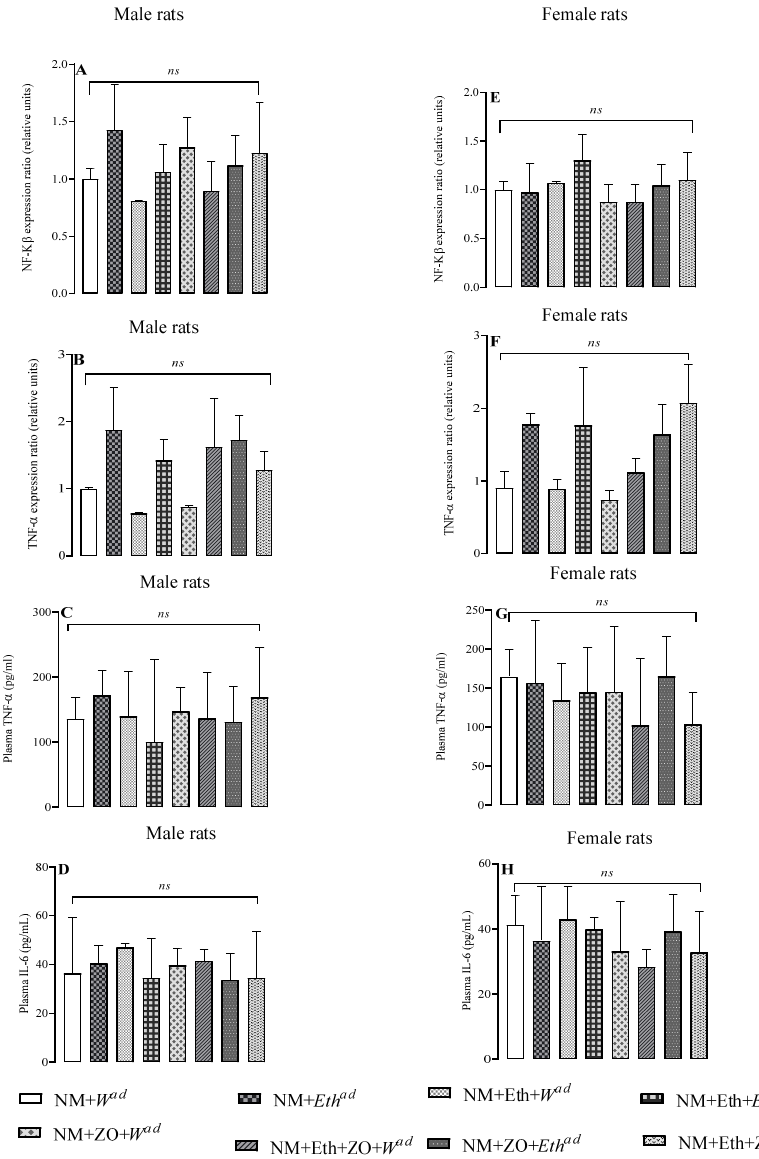
Figure 7. Effect of neonatal orally administered zingerone on NF-K β gene expression ( A , E ), TNF- α ( B , F ) gene expression, plasma TNF- α ( C , D ) and plasma IL-6 ( D , H ) concentrations in male and fe ‐ male rats drinking alcohol in adulthood. Data are presented as mean ± sd. a,a = Bars with same letters are not significantly different at p > 0.05. Control (NM + W ad )—neonatally gavaged with nutritive milk (NM) and drank plain drinking water ( W ad ) at stage III; late single hit (NM + Eth ad )—neonatally gavaged with NM and drank ethanol ( Eth ad ) solution at stage III; early single hit (NM + Eth + W ad )— neonatally gavaged with ethanol in nutritive milk and drank plain drinking water ( W ad ) at stage III; double hit (NM + Eth + Eth ad )—neonatally gavaged with Eth in nutritive milk and drank Eth ad at stage III; zingerone alone (NM + ZO + W ad )—neonatally gavaged with ZO in nutritive and drank plain drinking water ( W ad ) at stage III; early single hit with zingerone (NM + Eth + ZO + W ad )— neonatally gavaged with NM, Eth, ZO and drank plain drinking water ( W ad ) at stage III; late single hit with zingerone (NM + ZO + Eth ad )—neonatally gavaged with NM and ZO and drank Eth ad at